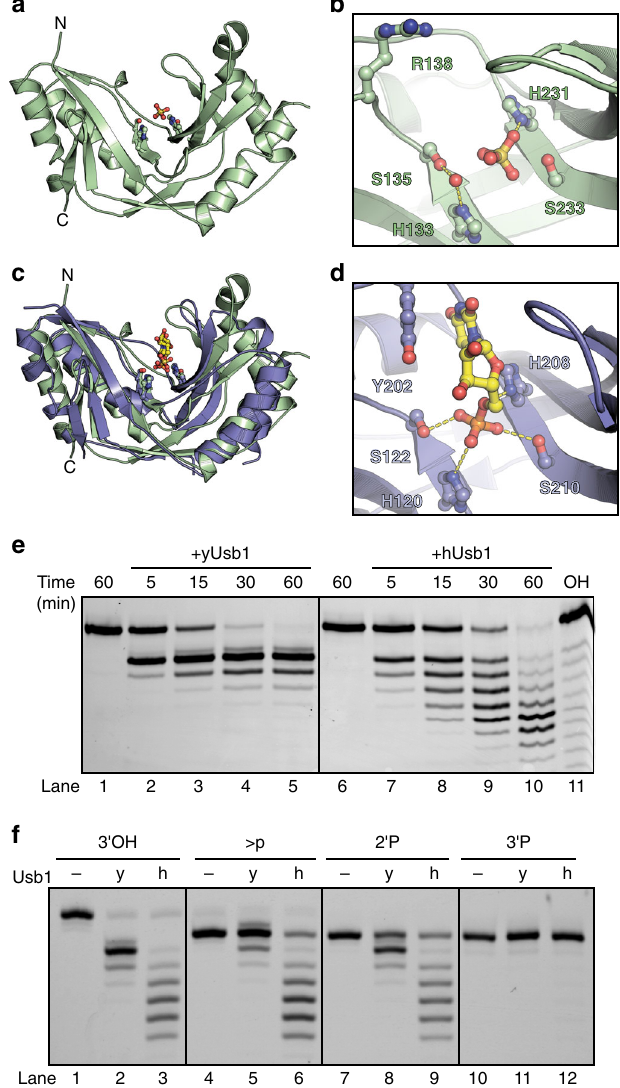
Fig. 2 Structure of yUsb1 and structure of hUsb1 with a substrate analog bound in the active site. a Structure of yUsb1 at 1.8 Å. Residues 1 – 70 were excluded from the crystallizable construct as they were predicted to be unstructured. The two active site H-X-S motifs are shown in ball-and-stick representation. b Active site of yUsb1. A sulfate ion is coordinated in the center of the H-X-S motifs. A water molecule is coordinated by histidine 133 and serine 135. ( c ) Structure of hUsb1 with 5 ′ UMP in the active site ( blue ; 5 ′ UMP in yellow ) is similar to the structure of yUsb1 ( green ). Residues 1 – 78 were truncated to facilitate crystallization. The two active site H-X-S motifs are shown in sticks . d Active site of hUsb1. 5 ′ UMP is coordinated in the center of the H-X-S motifs. The 5 ′ phosphate is positioned similarly to the sulfate ion in the yUsb1 structure ( b ). Tyrosine 202 makes a stacking interaction with the uracil of 5 ′ UMP. Hydrogen bonds between histidine 208 and the O5 ′ oxygen and between serine 122, histidine 120 and serine 210 and the phosphate hold 5 ′ UMP in the active site. e Time course comparing yUsb1 (lanes 1 – 5) and hUsb1 (lanes 6 – 10) activity. An alkaline hydrolysis ladder (lane 11) shows the mobility of oligonucleotide products of different length. f Single time-point (60 min) comparison of yUsb1 (y) and hUsb1 (h) on RNA substrates with different 3 ′ modi fi cations. Both yUsb1 and hUsb1 are most active on 2 ′ ,3 ′ - cis -diol RNAs (lanes 1 – 3), less active on cyclic phosphate (lanes 4 – 6) and 2 ′ phosphate (lanes 7 – 9) RNAs and inactive on 3